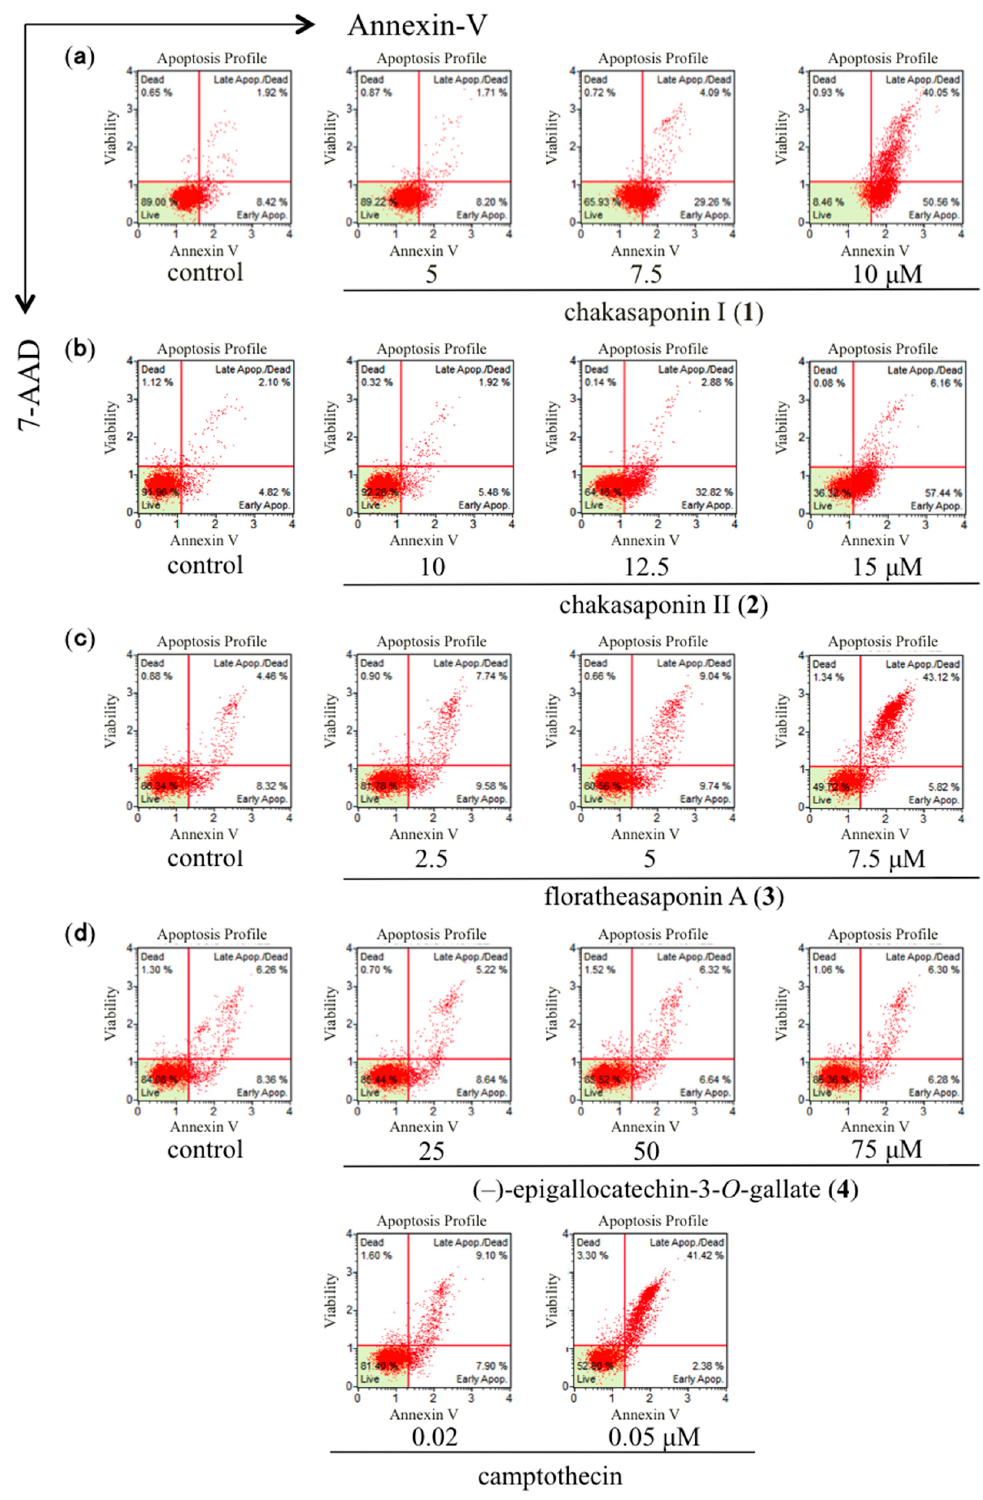
Figure 3. Effects of 1 – 4 and camptothecin on the apoptosis of HSC-2 cells. Annexin-V-binding was measured by Muse ® Cell Analyzer using a Muse Annexin-V and Deal Cell Kit (Merck Millipore); HSC-2 cells were treated with ( a ) 5, 7.5, and 10 µM of 1 ; ( b ) 10, 12.5, and 15 µM of 2 ; ( c ) 2.5, 5, and 7.5 µM of 3 ; ( d ) 25, 50, and 75 µM of 4 and 0.02 and 0.05 µM of camptothecin for 24 h; the data represent the mean percentages ± SD of total apoptosis ( n = 3); commercial camptothecin was purchased from Wako Pure Chemical Industries, Ltd. (Osaka, Japan).